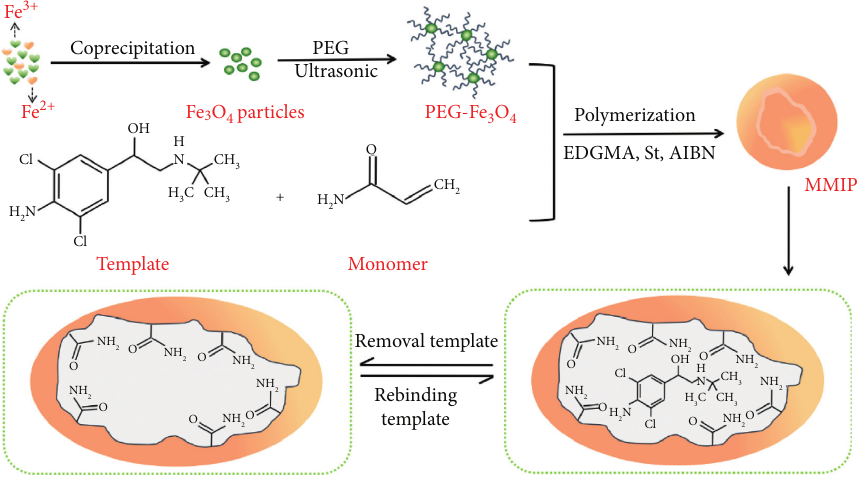
Figure 1: Schematic preparation procedure for CLB MMIPs.